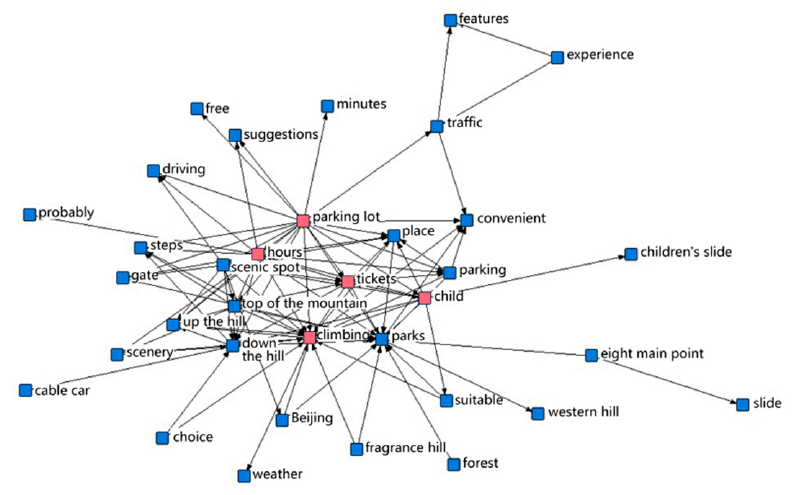
Figure 11. The semantic network of local tourists’ evaluations.